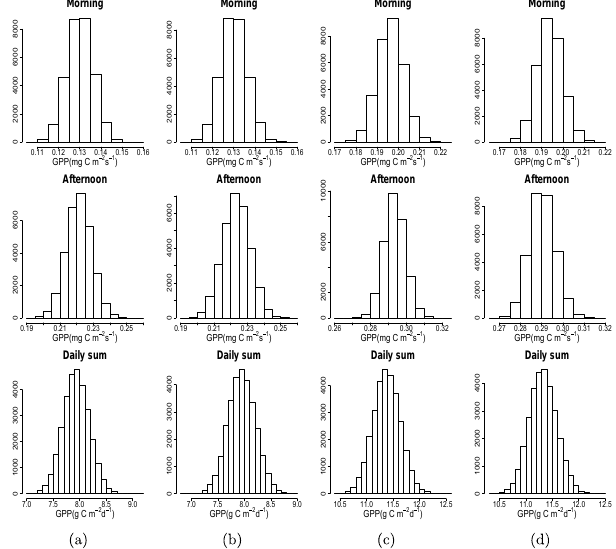
Figure 3. Histograms of half hourly GPP (Morning and afternoon) and daily sum of GPP when using the following: (a) informative priors on Julian day 121 (1 May 2009), (b) non-informative pri- ors on Julian day 121, (c) informative priors on Julian day 196 (15 July 2009), (d) non-informative priors on Julian day 196. The morn- ing and afternoon time belong to half-hour 08:00 to 08:30 and 13:00 to 13:30CET respectively. The y axis is frequency; CET is Central European Time.